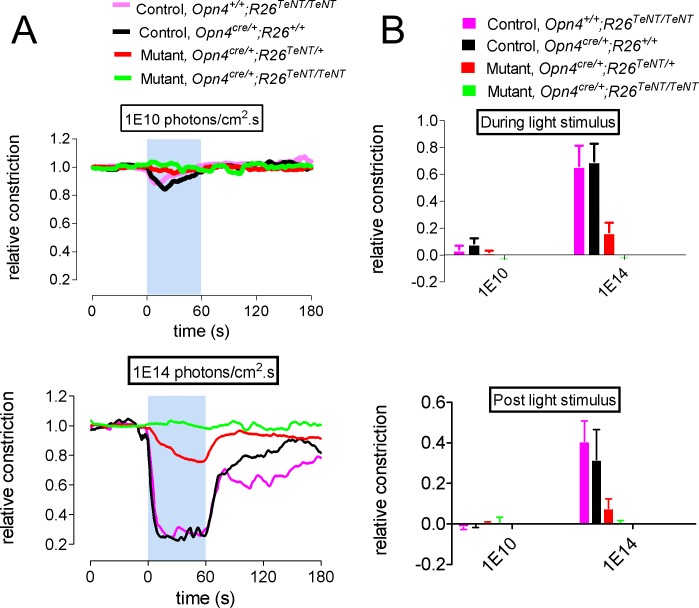
Synaptic “silencing” of ipRGCs and loss of pupillary light reflex (PLR) in Opn4::TeNT mice.(A) Opn4Cre/+ mice were intercrossed with R26floxstop-TeNT mice that have the TeNT gene integrated into the Rosa26 locus downstream of a floxed transcriptional stop sequence. Expression of Cre recombinase in ipRGCs excises the stop sequence to activate TeNT expression irreversibly. (B) Representative images of pupillary constriction 20 s post-irradiation in control and Opn4::TeNT mice. White broken lines encircle pupillary diameters. (C) Relative pupil area upon light stimulation of control and Opn4::TeNT mice with low and high light intensities. Values denote means ± SEM (n  =  3–5). *p<0.001.